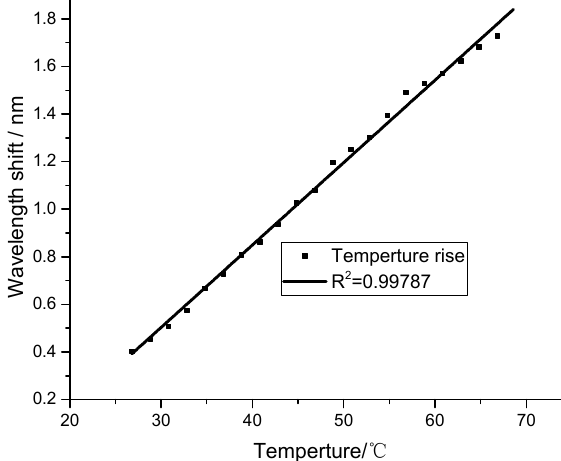
Figure 4. Temperature responding results. Compared with the humidity responding results in Figure 3, the temperature influence can be evaluated. The temperature change of the humidity responding test is shown in Figure 5. The temperature is nearly kept at 26.8 ◦ C. The max temperature difference in measurements is 0.6 ◦ C. This means the max wavelength shift caused by a temperature change is 0.0198 nm. The influence to humidity responding results is very slight on a whole measurement scale, which can be ignored.